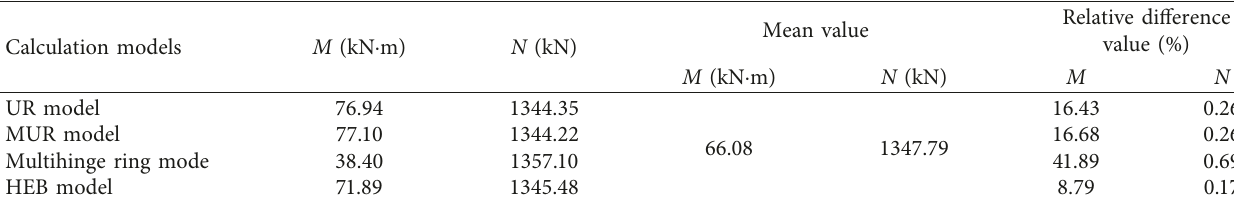
Table 3: Results comparison of inner force on crown section.